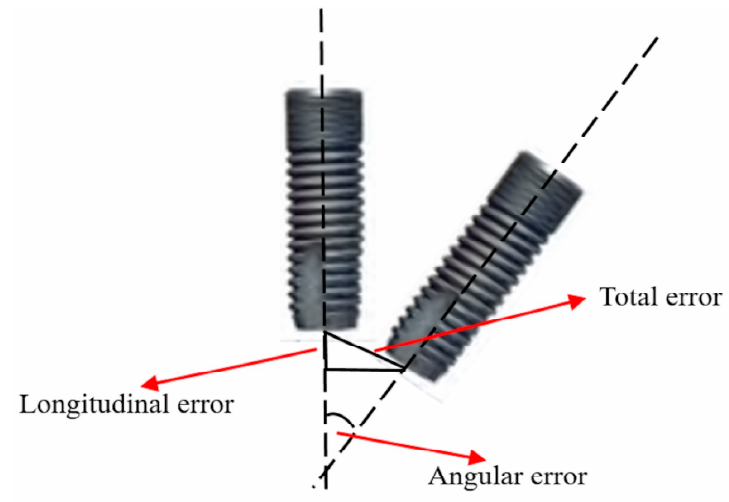
Figure 3. Total error (mm), longitudinal error (mm), and angular error (degree) measurement.